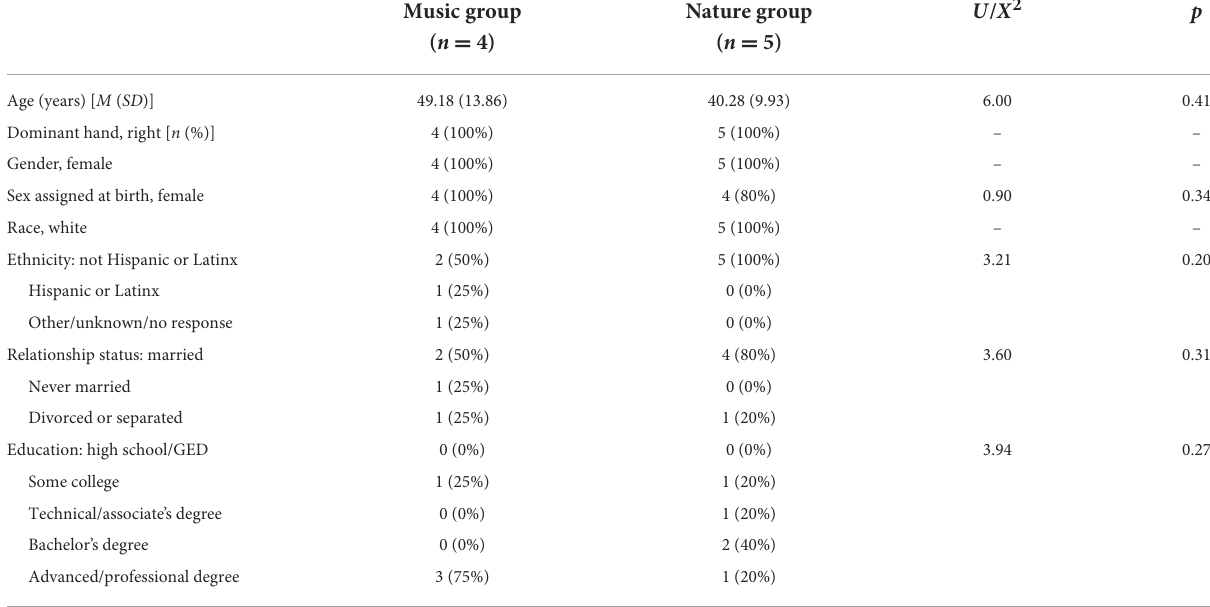
TABLE 1 Participant demographic variables by audio group assignment (Music,